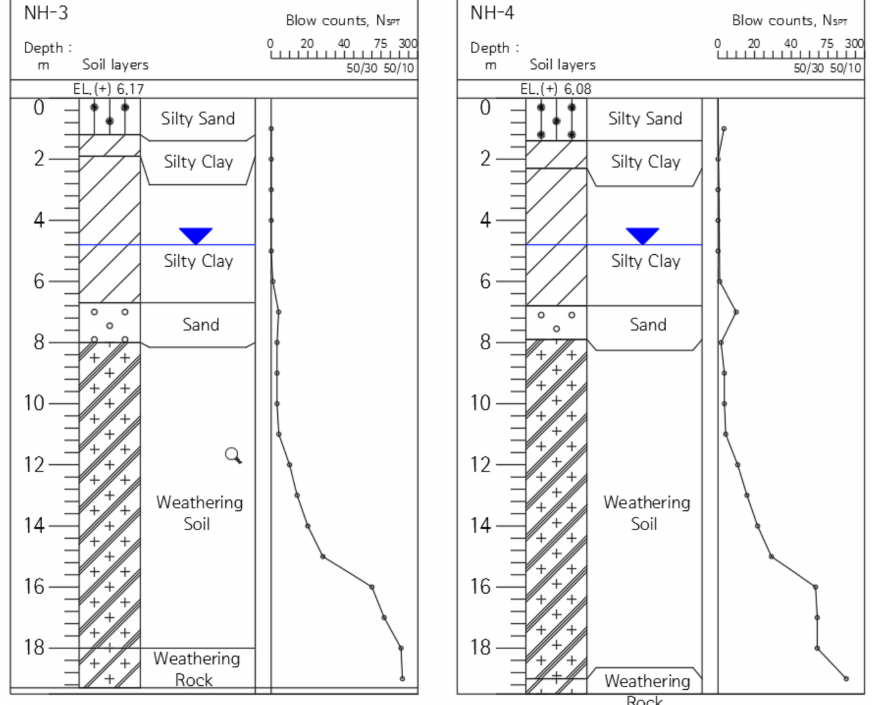
Figure 5. Sectional view of the Site-2 stratum.